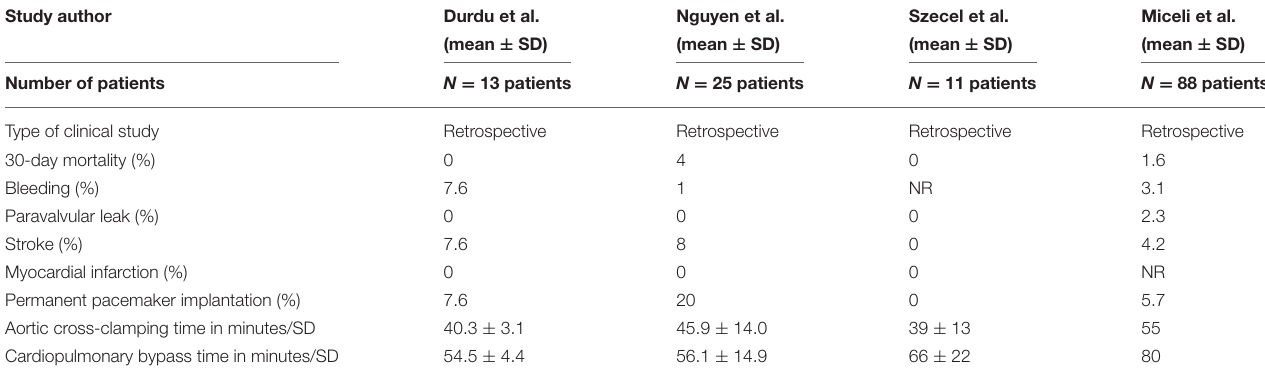
TABLE 3 | Clinical outcomes of bicuspid aortic valve stenosis treated with sutureless valve.